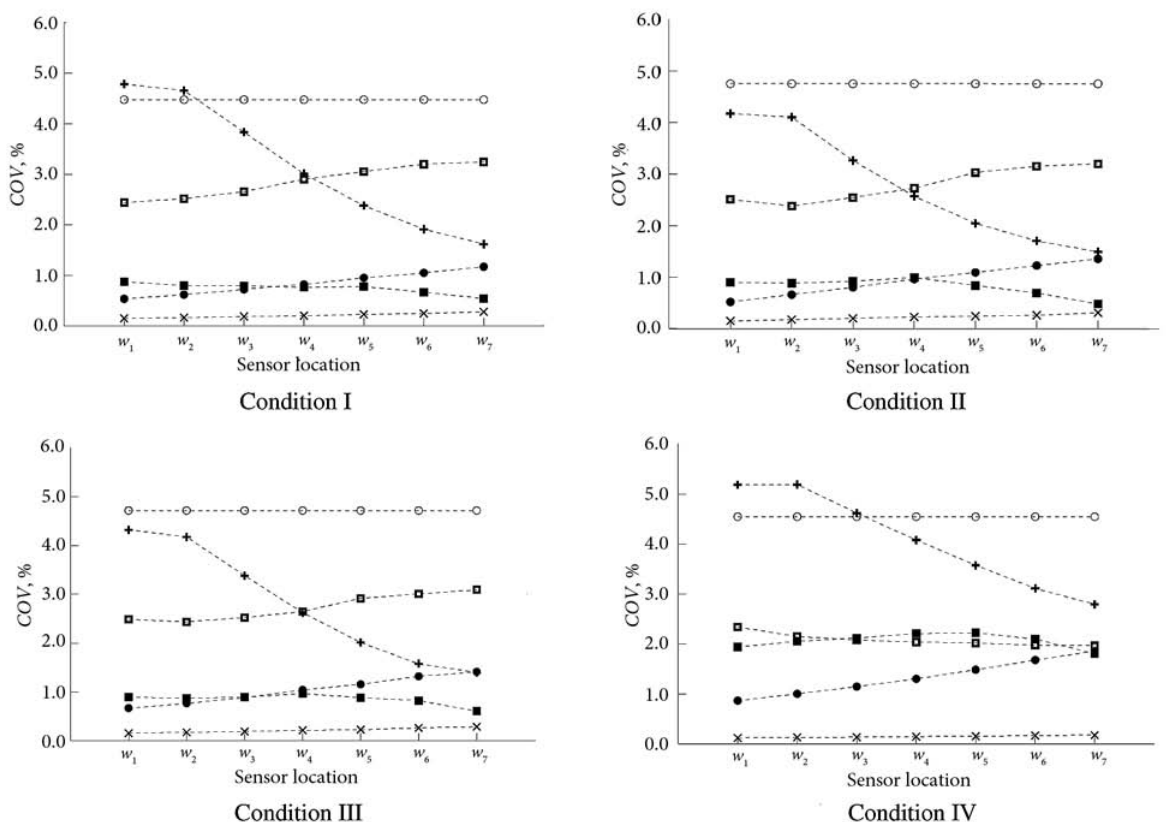
Fig. 3. COV ’s of max deflection data according to material uncertainties for half space boundary